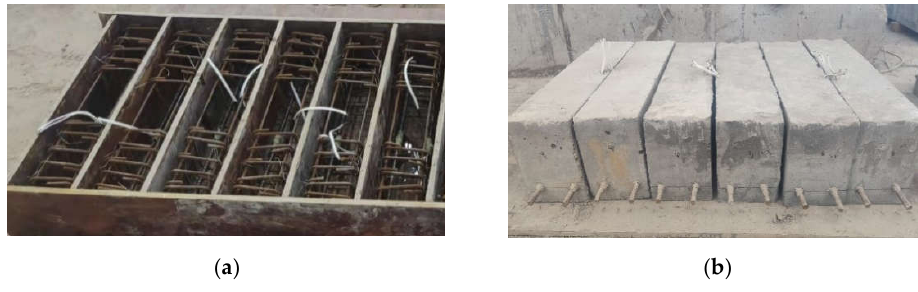
Figure 1. Details of test specimens (unit: mm): ( a ) Geometry; ( b ) Midspan section.